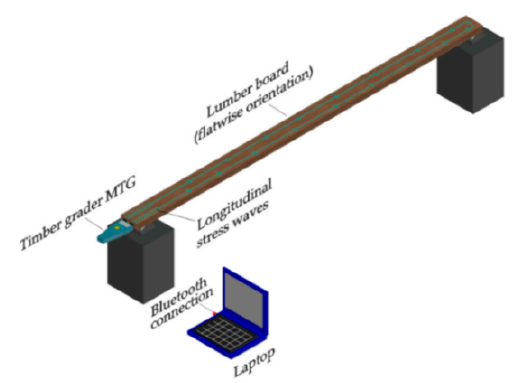
Figure 2. Longitudinal vibration test set